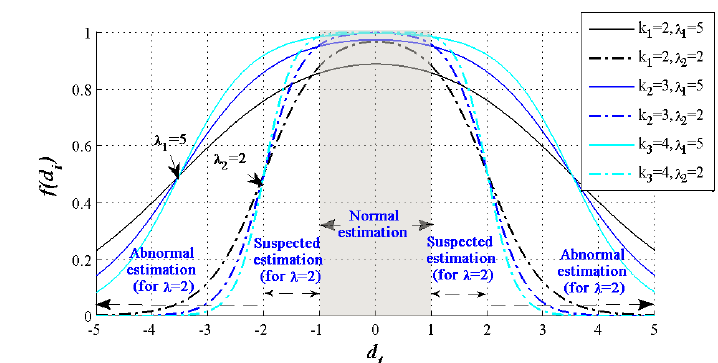
Figure 7. Curves of f ( d i ) with different λ and k .